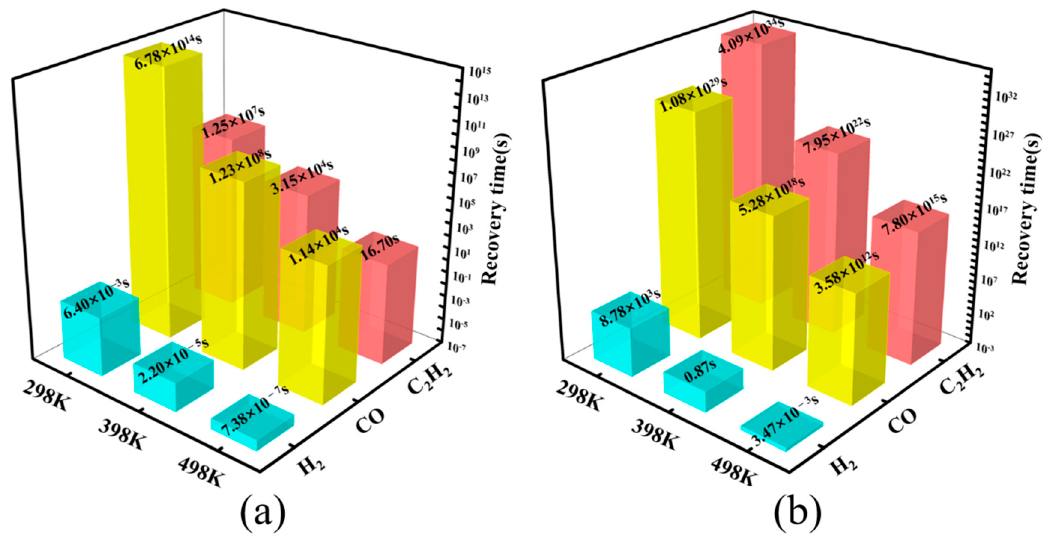
Figure 14. Recovery time of ( a ) Pd-GaSe adsorption system and ( b ) Pd 3 -GaSe adsorption system.